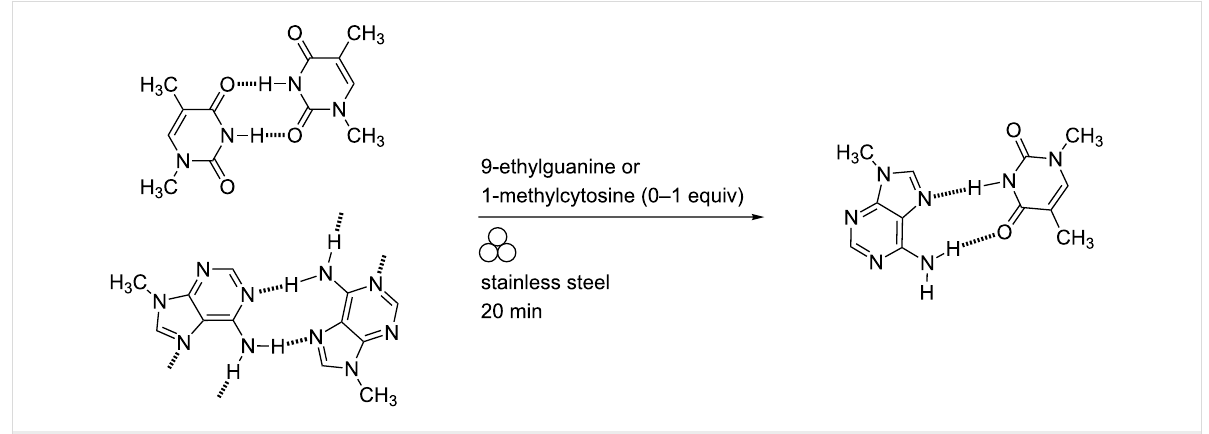
Scheme 16: Co-crystal grinding of alkylated nucleobases in an amalgam mill (N.B. no frequency was recorded in the experimental description).